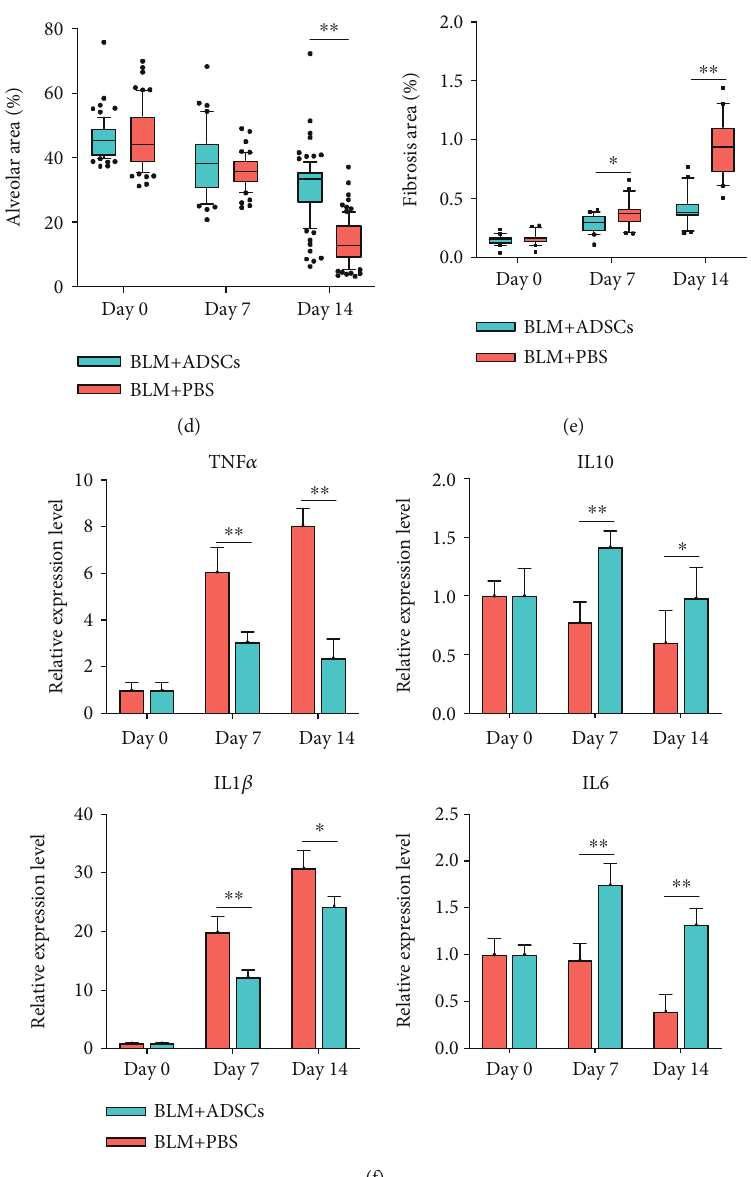
Figure 1: Intratracheal injection of ADSCs alleviated mouse pulmonary fi brosis. (a) The diagram of the study. (b) Kaplan-Meier survival curve for pulmonary fi brosis mice. The group was received PBS ( n = 10 , black line), the BLM + PBS group administered 3.5mg/kg BLM in 50 ul PBS at day 0 ( n = 21 , red line), and BLM + ADSCs group received 5 × 10 ^ 5 cell in 50 ul PBS by intratracheally at day 3 post- BLM administration. (c) Masson ’ s and H&E staining images of the lung tissues of mice on day 14, scale bar: 200 μ m. (d) Density of pulmonary fi brotic tissue ( fibrosisarea ð black arrow Þ /total area × 100 % ) calculated on histological sections of Masson ’ s trichrome staining. (e) Density of the pulmonary tissue ( alveolar ð red star Þ area ÷ parenchyma ð black star Þ area × 100 % ) calculated on histological sections of H&E trichrome staining. (f). Relative expression of TNF- α , IL-1 β , IL-10, and IL-6 mRNA in the pulmonary tissue of BLM + ADSC and BLM + PBS group ( n = 3 each) determined by quantitative real-time polymerase chain reaction, on days 7 and 14. Data presented as mean ± SD with signi fi cance based on Student t -test. ∗ P < 0 : 05 ; ∗∗ P < 0 : 01